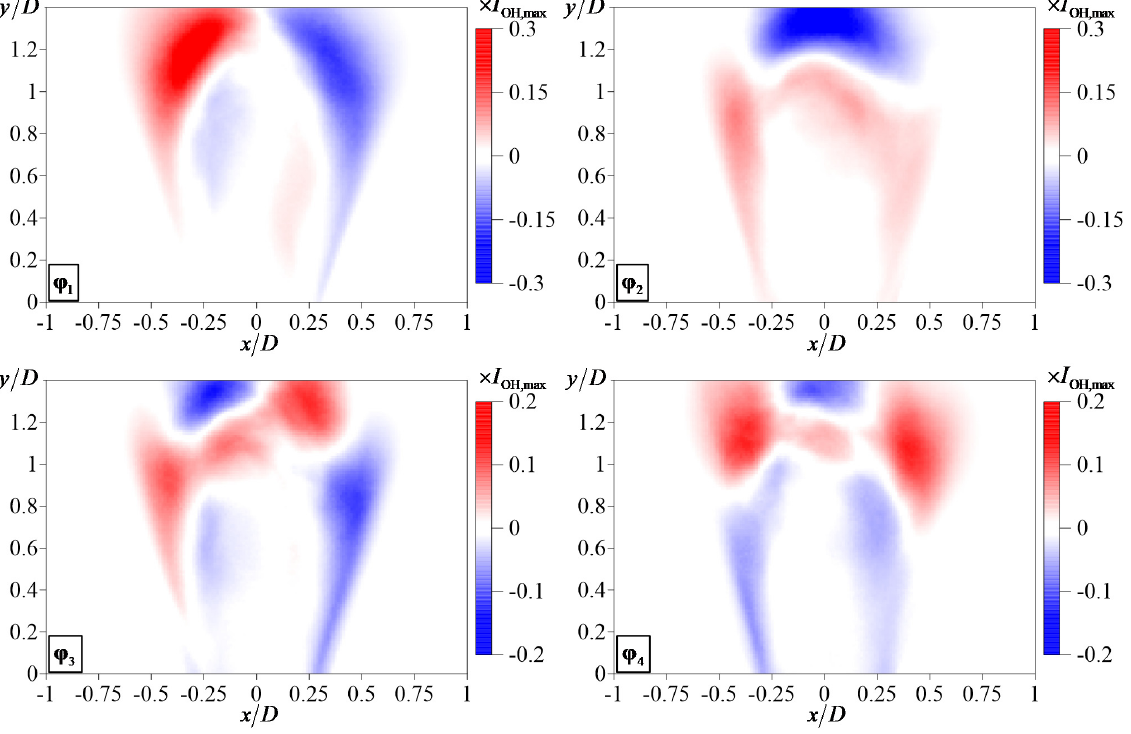
Figure 17. First four PCA modes of OH* chemiluminescence images for syngas flame at normal conditions.